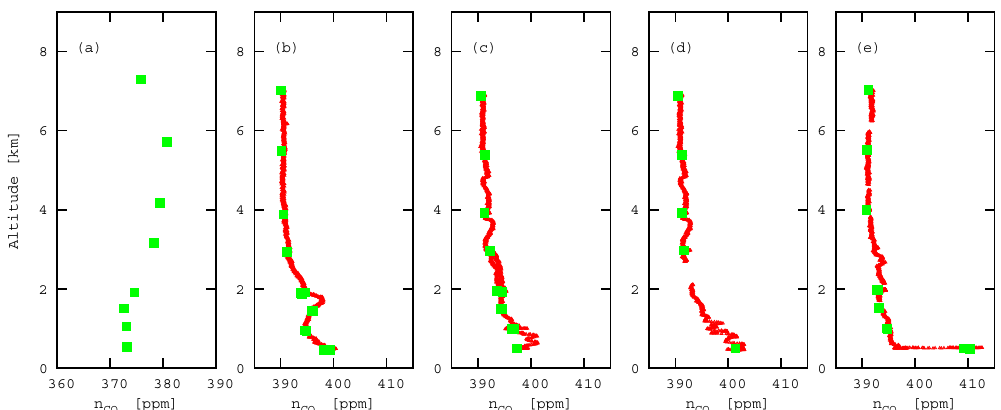
Fig. 7. Atmospheric CO 2 profiles from airborne flask (green squares) and in situ devices (red points). (a) 26 August 2009, taken over Moshiri (0–7km); (b) 14 February 2010; and (c) 20 February 2010, over Kumagaya (2–7km) and Tsukuba (0.5–2km); (d) 20 February 2010 over Kumagaya (2–7km) and Koganei (0.5–3km); (e) 23 February 2010, over Kumagaya (2–7km) and Tsukuba (0.5–2km).